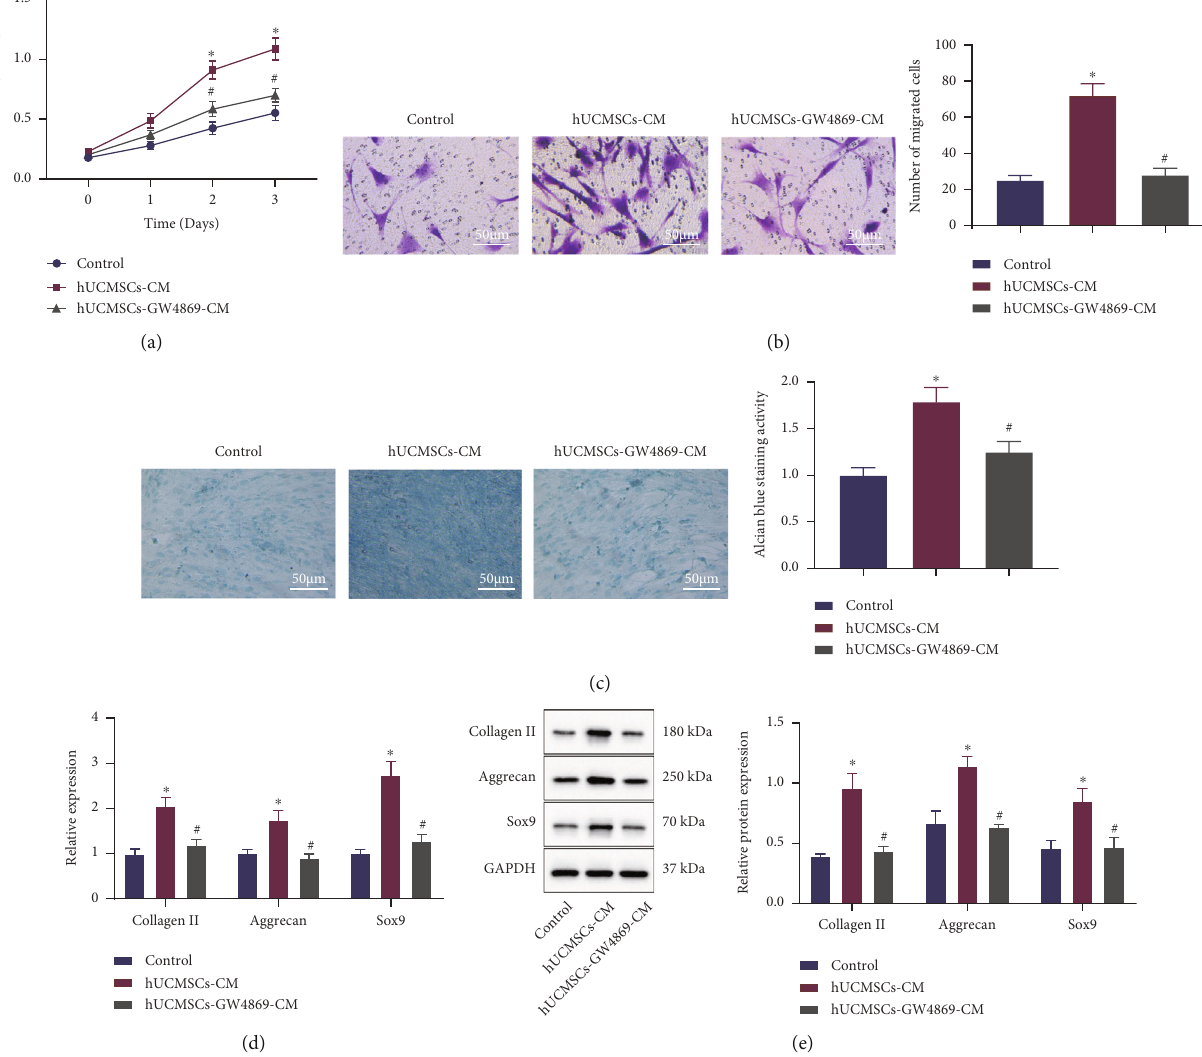
Figure 2: E ff ect of hUCMSC-EVs on the proliferation, migration, and cartilage di ff erentiation of BMSCs. BMSCs were treated with hUCMSC-CM alone or combined with hUCMSC-GW4869-CM. (a) Proliferation of BMSCs was detected by the CCK8 assay. (b) Migration of BMSCs was detected by the Transwell assay ( scale bar = 50 μ m ). (c) Cartilage di ff erentiation ability of BMSCs was detected by Alcian blue staining ( scale bar = 50 μ m ). (d) mRNA levels of collagen II, aggrecan, and Sox9 in BMSCs were determined by RT-qPCR. (e) Protein levels of collagen II, aggrecan, and Sox9 in BMSCs were measured by Western blot analysis. ∗ p < 0 : 05 , compared with the control; # p < 0 : 05 , compared with BMSCs treated with hUCMSC-CM. All experiments were repeated for three